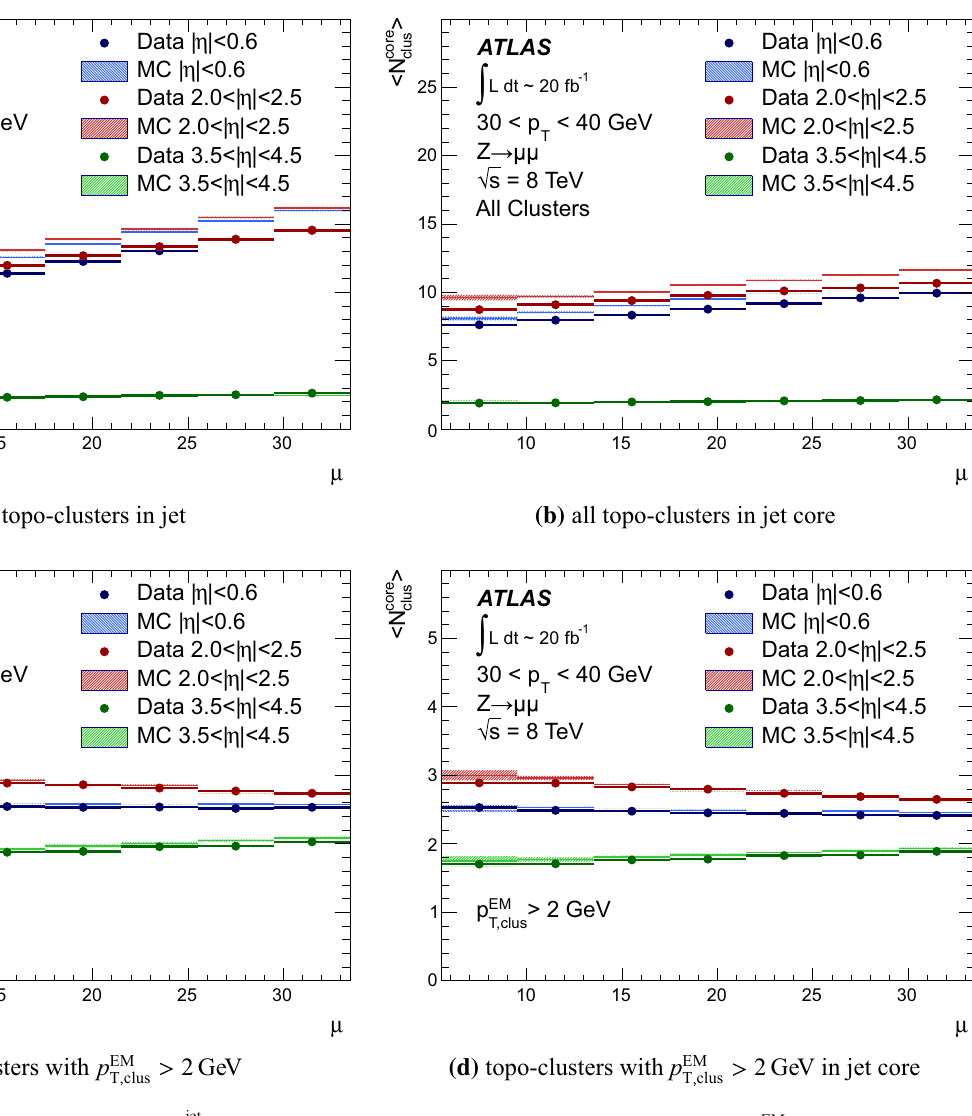
Fig. 33 The average number of topo-clusters (cid:7) N jet reconstructed with R = 0 . 4 within 30GeV < p LCW + JES a function of μ , in Z → μμ events in 2012 data and MC simulations ( a ). The pile-up dependence of the average number of topo-clusters (cid:7) N core in the core of the jet, defined by the distance to jet axis (cid:9) R < 0 . 3,